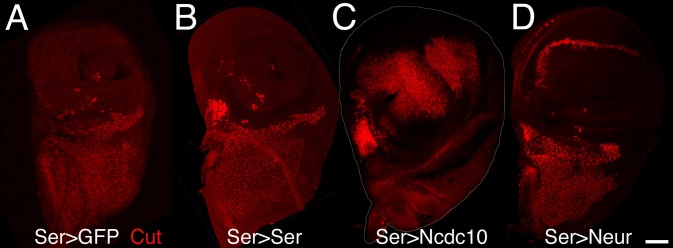
Expression of Neur in Dorsal Cells Is Sufficient to Rescue the D-mib Mutant Phenotype
D-mib2/D-mib3 mutant discs expressing GFP (A) (GFP staining not shown), Ser (B), Ncdc10 (C), or Neur (D) under the control of Ser-GAL4 were stained for Cut (red). Expression of Ser in dorsal cells did not rescue the D-mib2/D-mib3 wing pouch mutant phenotype (compare [B] with [A]), consistent with D-mib being required for Ser signaling. By contrast, expression of Ncdc10, an activated version of N, led to the deregulated growth of the dorsal compartment and the expression of Cut in most dorsal cells (C), indicating that activated N acts downstream of D-mib. Expression of Neur in dorsal cells was sufficient to compensate for the loss of D-mib activity (D).Bar is 40 μm for all panels.